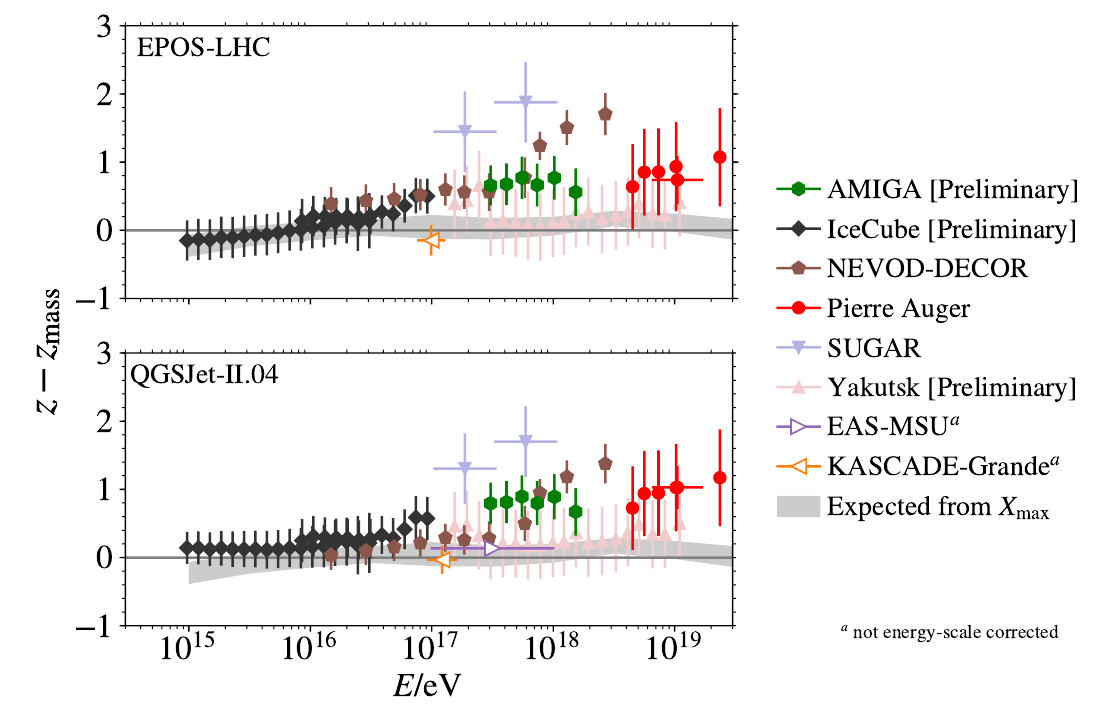
Figure 9. Data from Fig.8 after subtracting z mass . The points for KASCADE-Grande and EAS-MSU cannot be cross-calibrated and are only included for